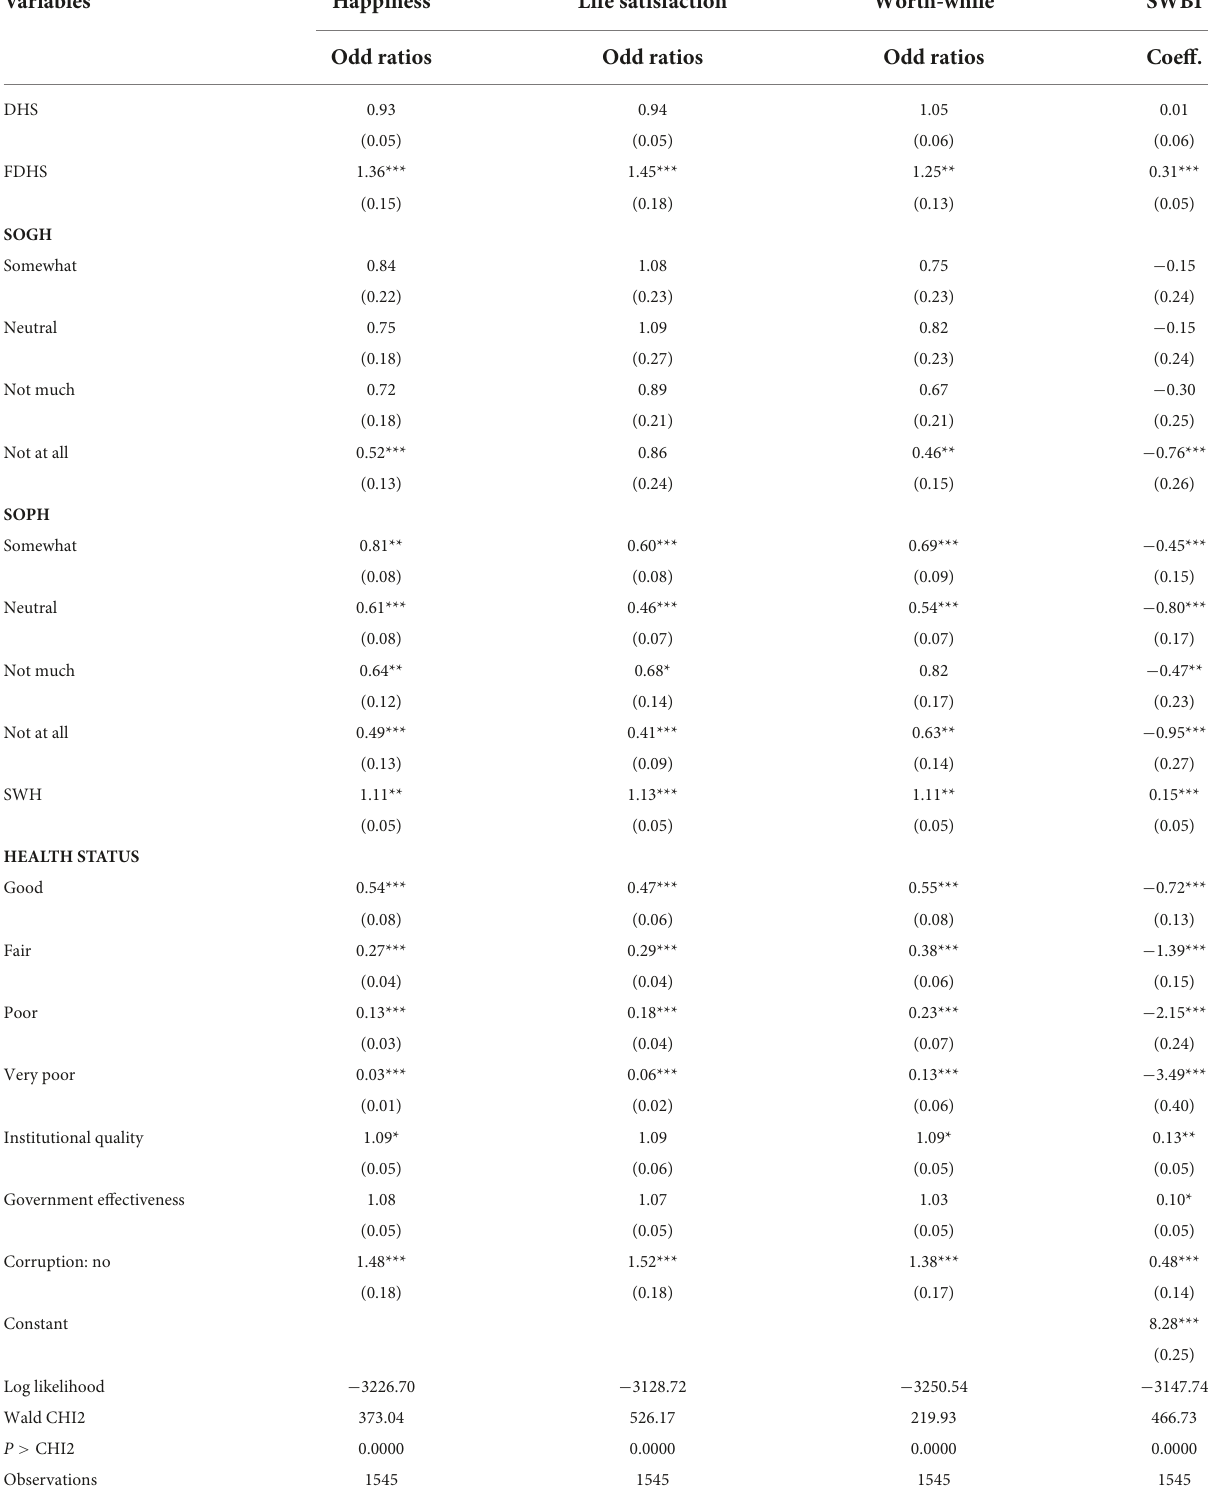
TABLE 6 Factors of health and institutions as determinants of subjective wellbeing method: Ordered logit model Ic. Variables Happiness Life satisfaction Worth-while SWBI Odd ratios Odd ratios Odd ratios